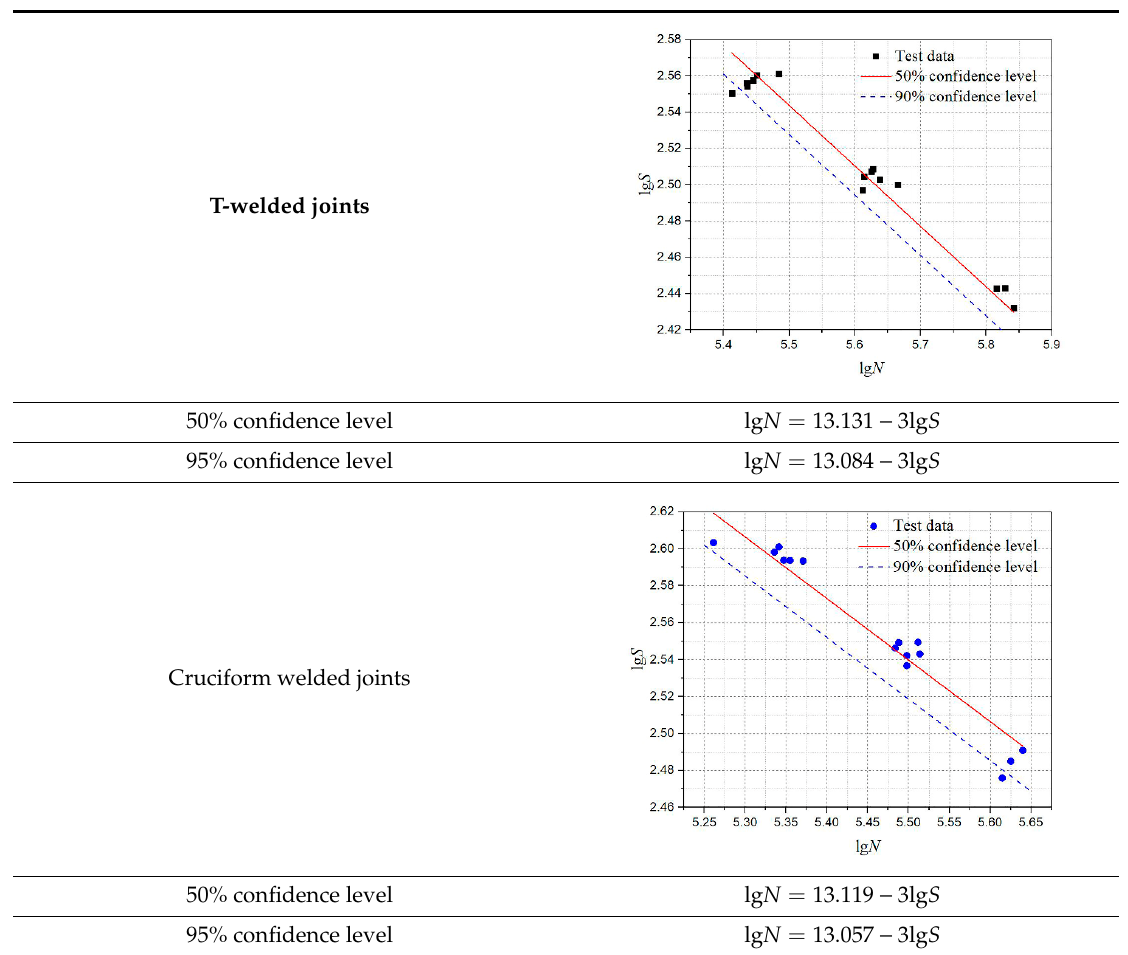
Table 5. Table 5. Double logarithmic S–N curve with confidence level. Table 5. Double logarithmic S–N curve with confidence level.